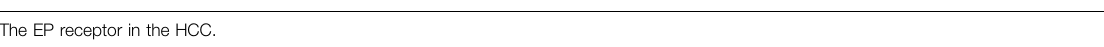
TABLE 1 | The EP receptor in the